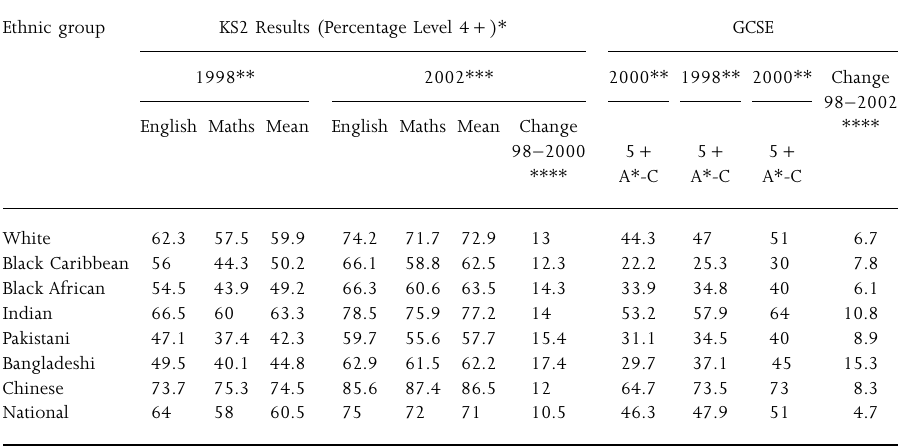
Table 4 Attainment by ethnic group in primary and secondary schools in England, 1998 and 2002 Ethnic